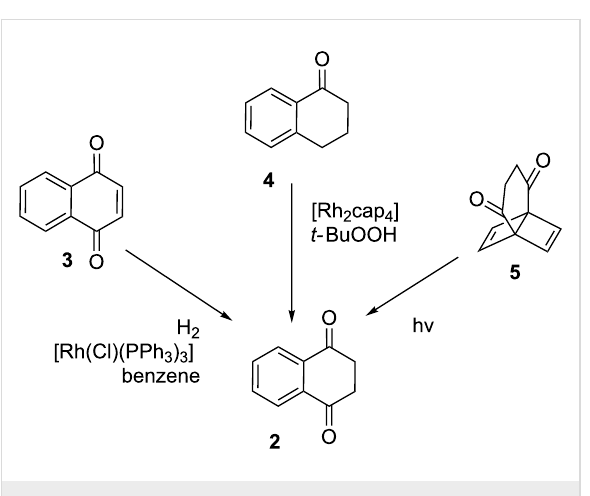
Scheme 2: Alternative routes of access to tetralin-1,4-dione.